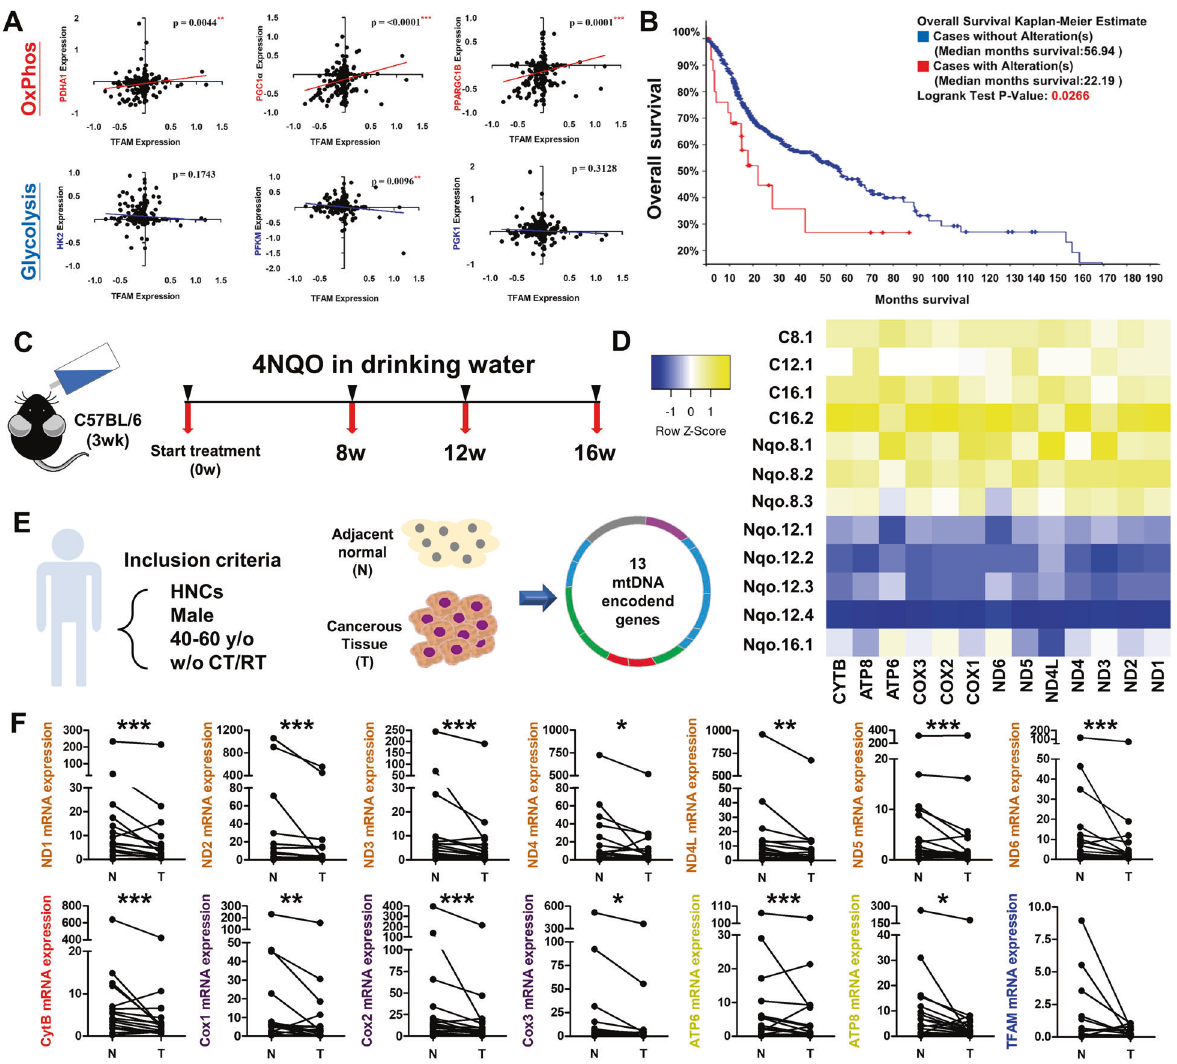
Fig. 6 Clinical Impacts of TFAM and mtDNA-encoded ETC in HNCs. A Mitochondrial factor (PDHA1, PGC1 α , PPARGC1 β ) were detected in TCGA based database; whereas negative correlations between TFAM and glycolytic enzymes (HK2, PFKM, PGK1) were found in HNCs using The Cancer Genome Atlas (TCGA) database ( N = 273). B Kaplan – Meier analysis for overall survival rates in HNC patients classi fi ed by TFAM genetic alteration using TCGA database ( N = 519). HNC cases with TFAM K141N mutational alteration have signi fi cant poorer overall survival ( N = 26, median months ’ survival: 22.19) than HNC cases without TFAM alteration(s) ( N = 462, median months survival: 56.94). C Experimental scheme of Nqo mediated induction for mouse tongue cancer. D Heatmap of mtDNA encoded ETC gene expression in control group (C; N = 4) and 4NQO treatment group (Nqo; N = 8). Rows represent control and Nqo treatment group; column represent 13 mtDNA encoded ETC genes. For different group, C/Nqo.X.Y is used where X indicates treatment time (weeks) and Y represents mouse number. The color scale runs from blue (low intensity) to white (medium intensity), to yellow (strong intensity) calculated by z-score. E , F Analysis for mtDNA encoded ETC genes in cancerous tissues (T) and their corresponding adjacent normal tissues ( N ) from HNC patients ( N = 18) with indicated criteria was performed using real-time RT-PCR analysis. Signi fi cant decreased mtDNA encoded ETC and TFAM mRNA expression in clinical tumourous tissues compared with their normal counterparts was detected. * p < 0.05, ** p < 0.01, *** p <